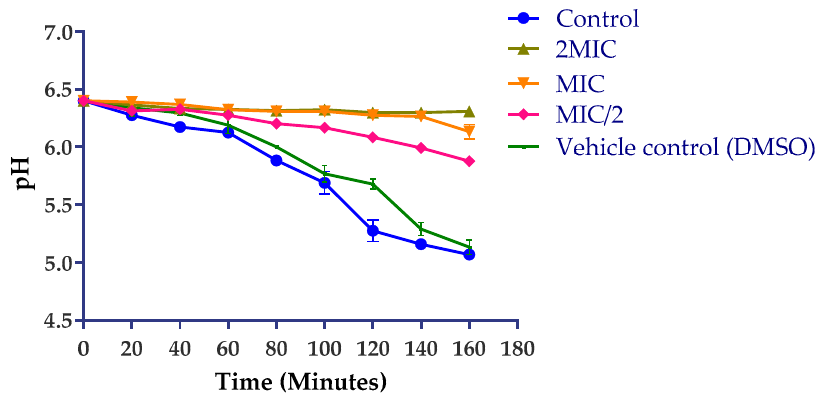
Figure 5. Action P. huayllabambana n-hexane fraction on S. enterica H + -ATPase-mediated proton pumping as a function of time. MIC: minimum inhibitory concentration. Data expressed as mean ± SD ( p < 0.05).